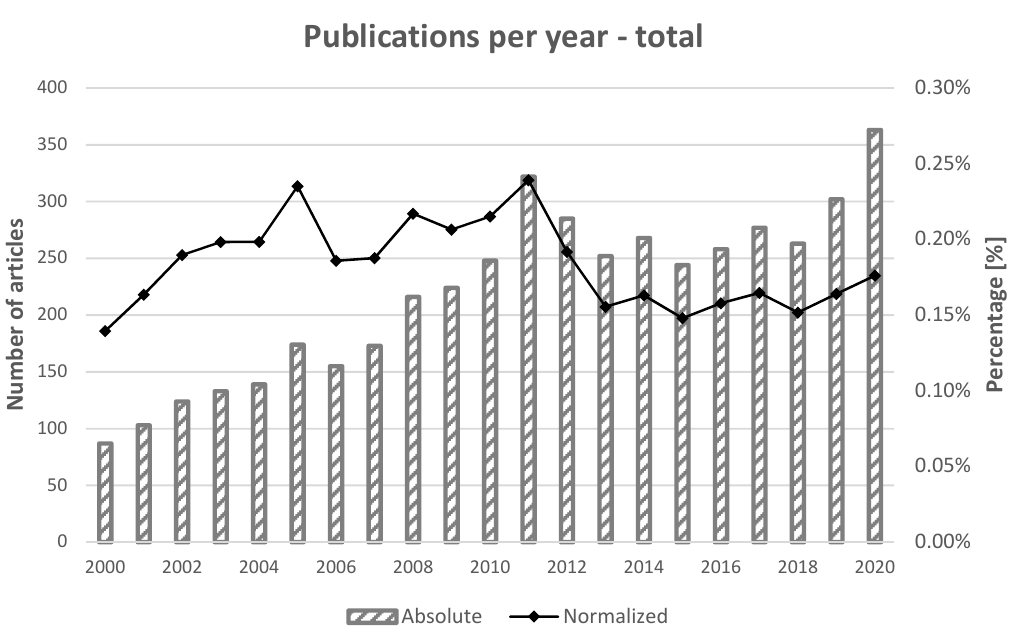
Figure 2. Publications per year (bars) and ratio between publications on the mulberry and silkworm topic in the sector “Agri” and total publications in Agricultural and Biological Science field (line).